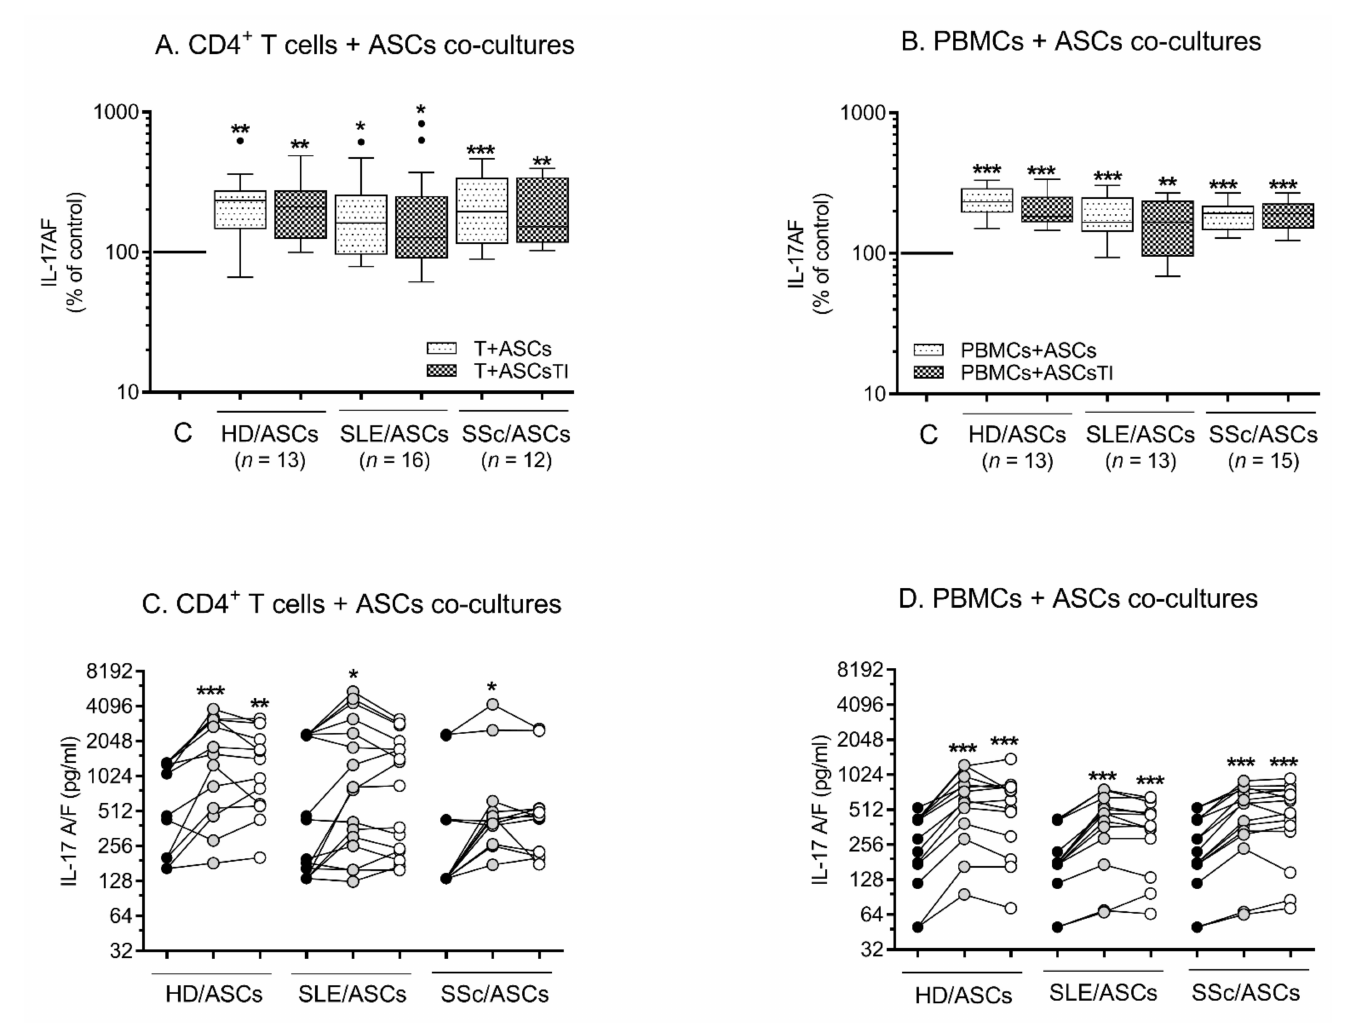
Figure 5. The effects of ASCs on the secretion of IL-17AF by activated target cells. Cell preparation and culture conditions as in Figures 3 and 4, except that HD/ASCs ( n = 5), SLE/ASCs ( n = 18), and SSc/ASCs ( n = 17) lines were co-cultured with activated T cells or activated PBMCs that were isolated from peripheral blood of 13 healthy volunteers. The concentrations of IL-17AF were measured in culture supernatants by specific ELISAs as described in the Materials and methods. ( A , B )—the results are expressed as the percentage of the cytokine levels regarding those found in separately cultured activated control target cells ( C ) and are shown as the Tukey’s boxes. ( C , D )—the same data shown as IL-17 AF concentrations in individual experiments in which lines between points identify cultures containing the same combination of ASCs and T cells ( A , C ) or PBMCs ( B , D ); n —the number of experiments performed. Black circles—separately cultured activated T cells ( C ) or PBMCs ( D ); grey circles—activated target cells + ASCs; unfilled circles—activated target cells + ASCs TI . * p = 0.05–0.01; ** p = 0.01–0.001; *** p = 0.001–0.0001 for intra-group comparison; the inter-group differences were statistically